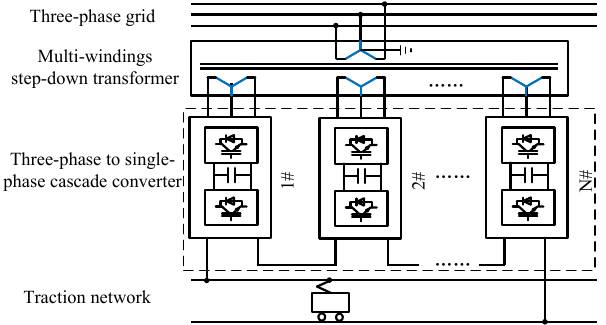
Figure 2. The diagram of proposed traction substation system in advanced traction power supply system (ATPSS).